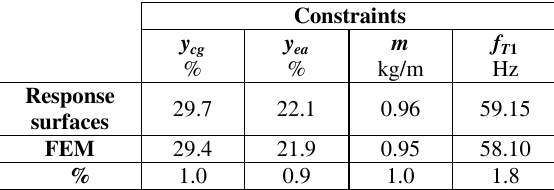
Table 2. Constraints